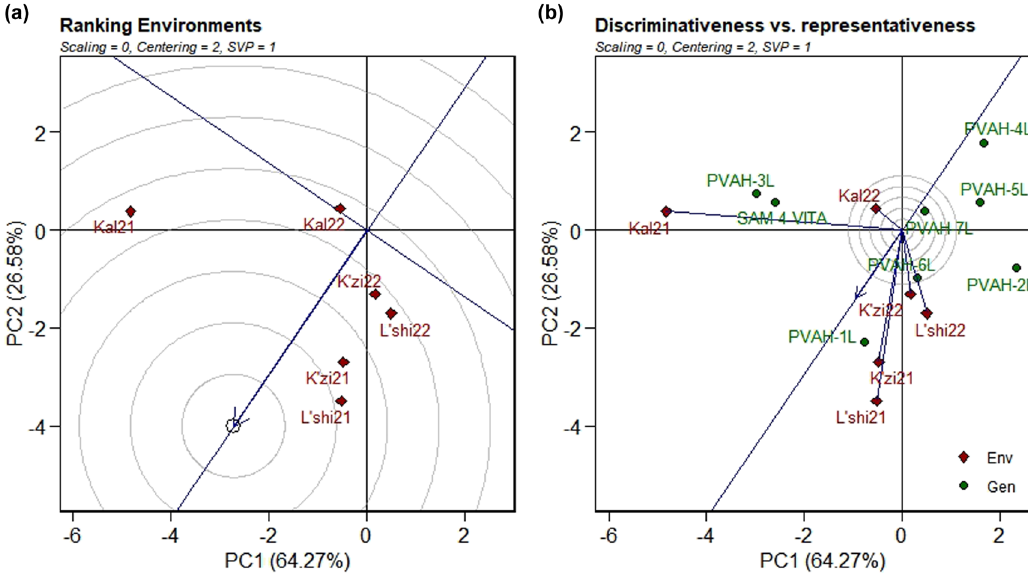
Figure 4: Visualization of “ ideal environment ” using GGE biplot. ( a ) Concentric circles show the position of ideal environments. ( b ) Environments closer to the ideal spot are